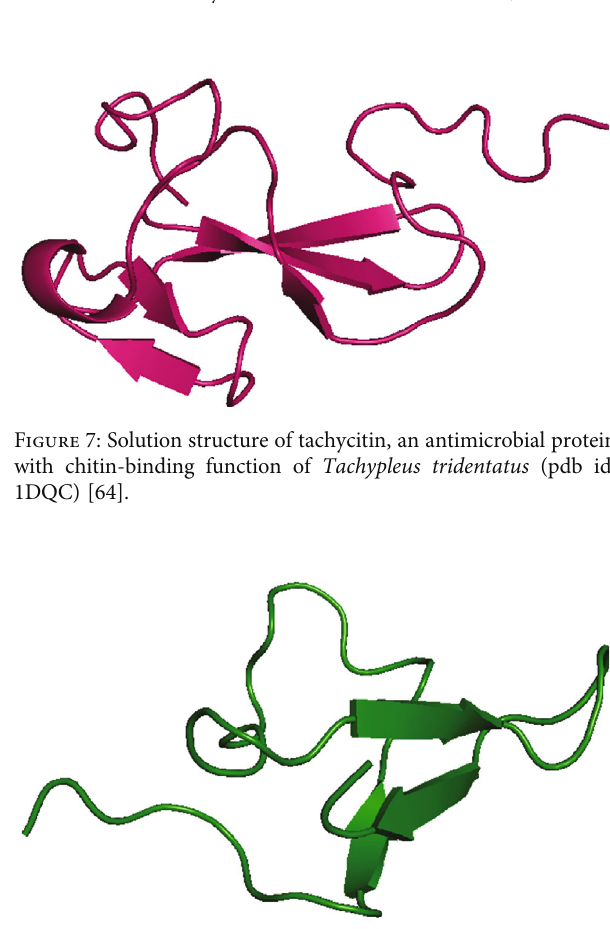
Figure 8: Tachystatin B isolated from the horseshoe crab, Tachypleus tridentatus (pdb id: 2DCW) [66].